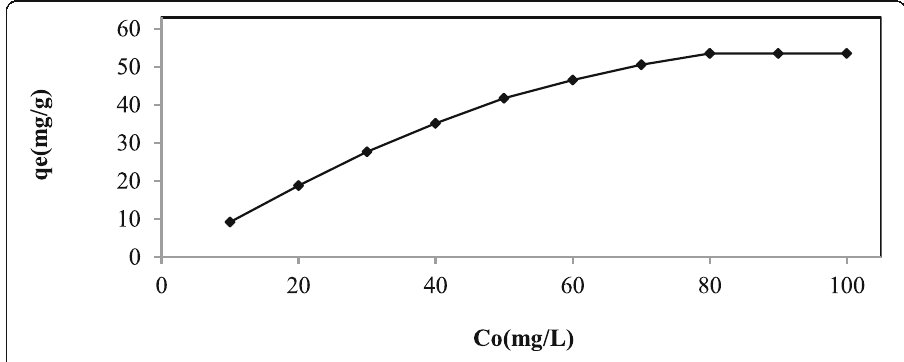
Fig. 9 Effect of initial concentration on nickel